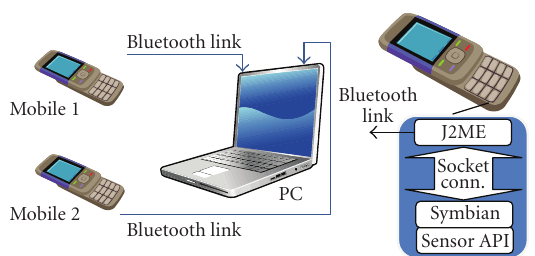
Figure 6: Phone game controller communication